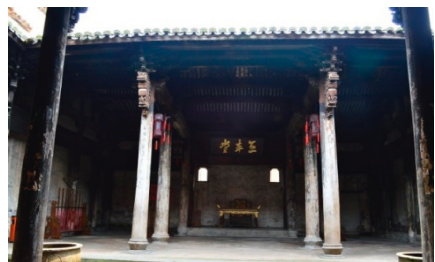
Figure 3: Elevation graph of Liben hall.